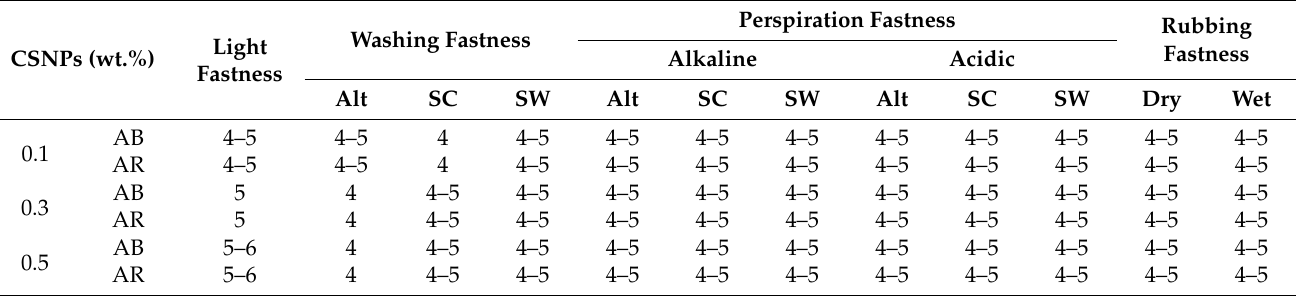
Table 2. Fastness properties of CSNPs treated cotton fabrics and dyed with two acid dyes at 0.2 wt.% nonionic detergent at 88 ◦ C for 30 min.